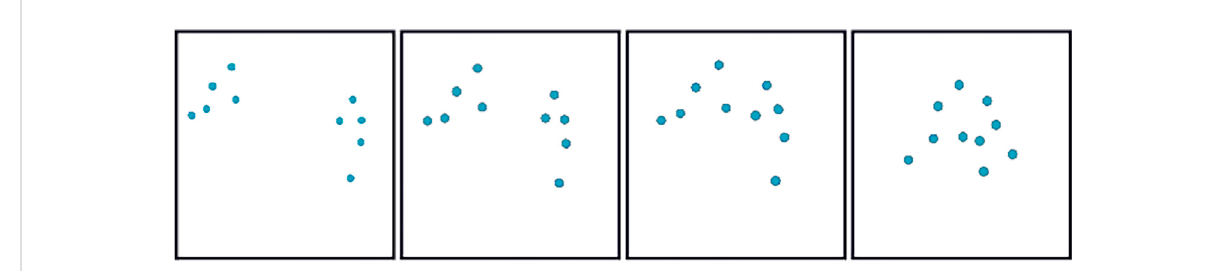
FIGURE 6 Fourconsecutivesnapshotsfromavideooftheexperimentsperformedwithcommunicationintheloop.Eachsnapshotcapturesanaerialtop- down view of the swarm during the “ merging ” phase. The images have been changed in color for readability purposes and provide an illustrative example oftwosub-swarms merging into oneattheendofthediamond-shapedtrajectory designedfor theexperiments.Fortheoriginalvideo,see the supplementary material.